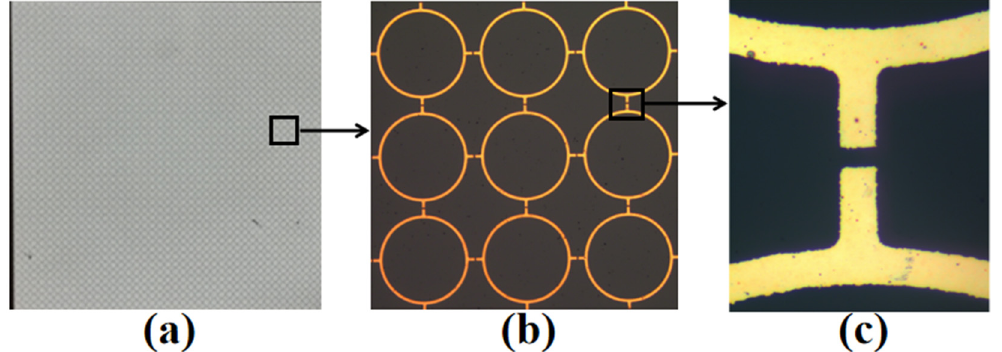
Figure 7. ( a ) Fabricated prototype of the proposed FSS; ( b ) Microscopic image of 3 × 3 array; ( c ) Zoom picture for highlighting the gap.